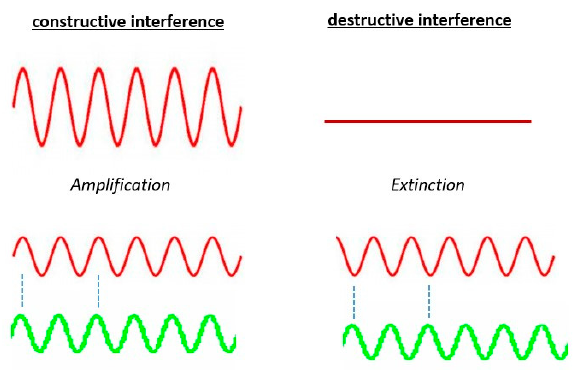
Figure 1. Constructive and destructive interference—concept and illustration.